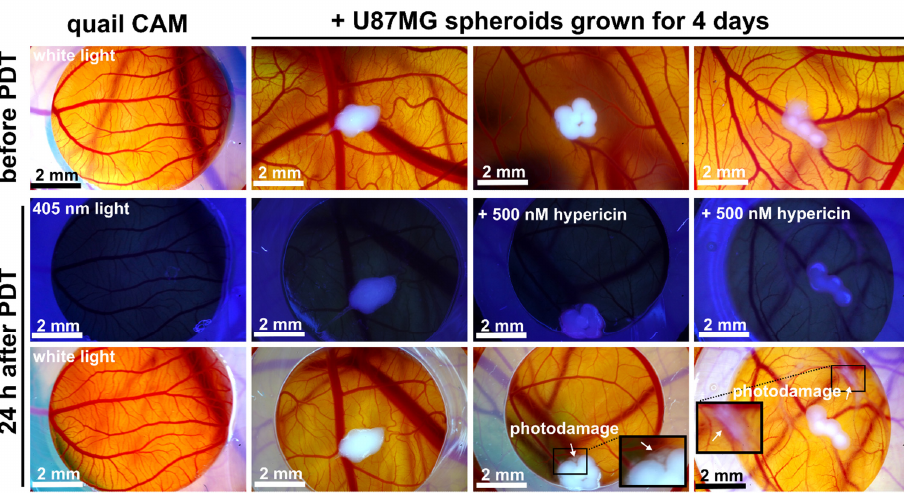
Figure 9. Representative color images of quail CAM without and with U87MG spheroids grown for 4 days and detected before PDT and hypericin administration (top panel). Fluorescence of CAM without and with spheroids, and without and with 500 nM hypericin (administered 3 h before PDT) was detected 24 h after PDT application (middle raw image). The last raw image corresponds to the color images of the same CAMs in white light. Insets are zoomed areas of photodamage caused by PDT. Experiment was repeated at least four times. Scale bar represents 2 mm. Histology of CAM with spheroids, hypericin administration, and irradiated only with photographic acquirement is shown in Figure 10. CAM without spheroids is shown in Figure 10A and U87MG cell spheroids are shown in Figure 10B. The cavities in the spheroids are due to the preparation technique. The invagination of the spheroidal cells into the ectoderm of CAM can be seen in the zoom images of Figure 10B,B’. Light damage caused by irradiation with the detection system was also observed, but only in the first cell layers of the spheroid (dark areas with asterisks).